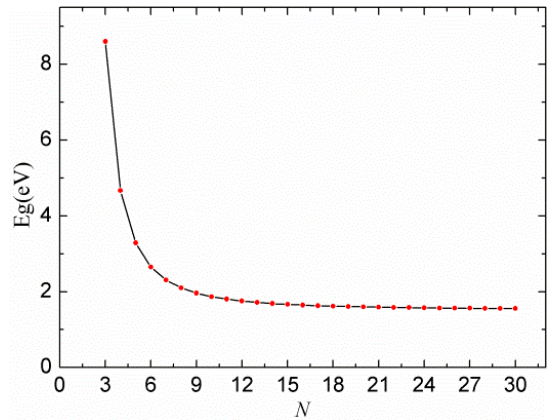
Figure 2. The band gap energies obtained as a function of the atom numbers in unit cell for armchair black phosphorus nanoribbons.